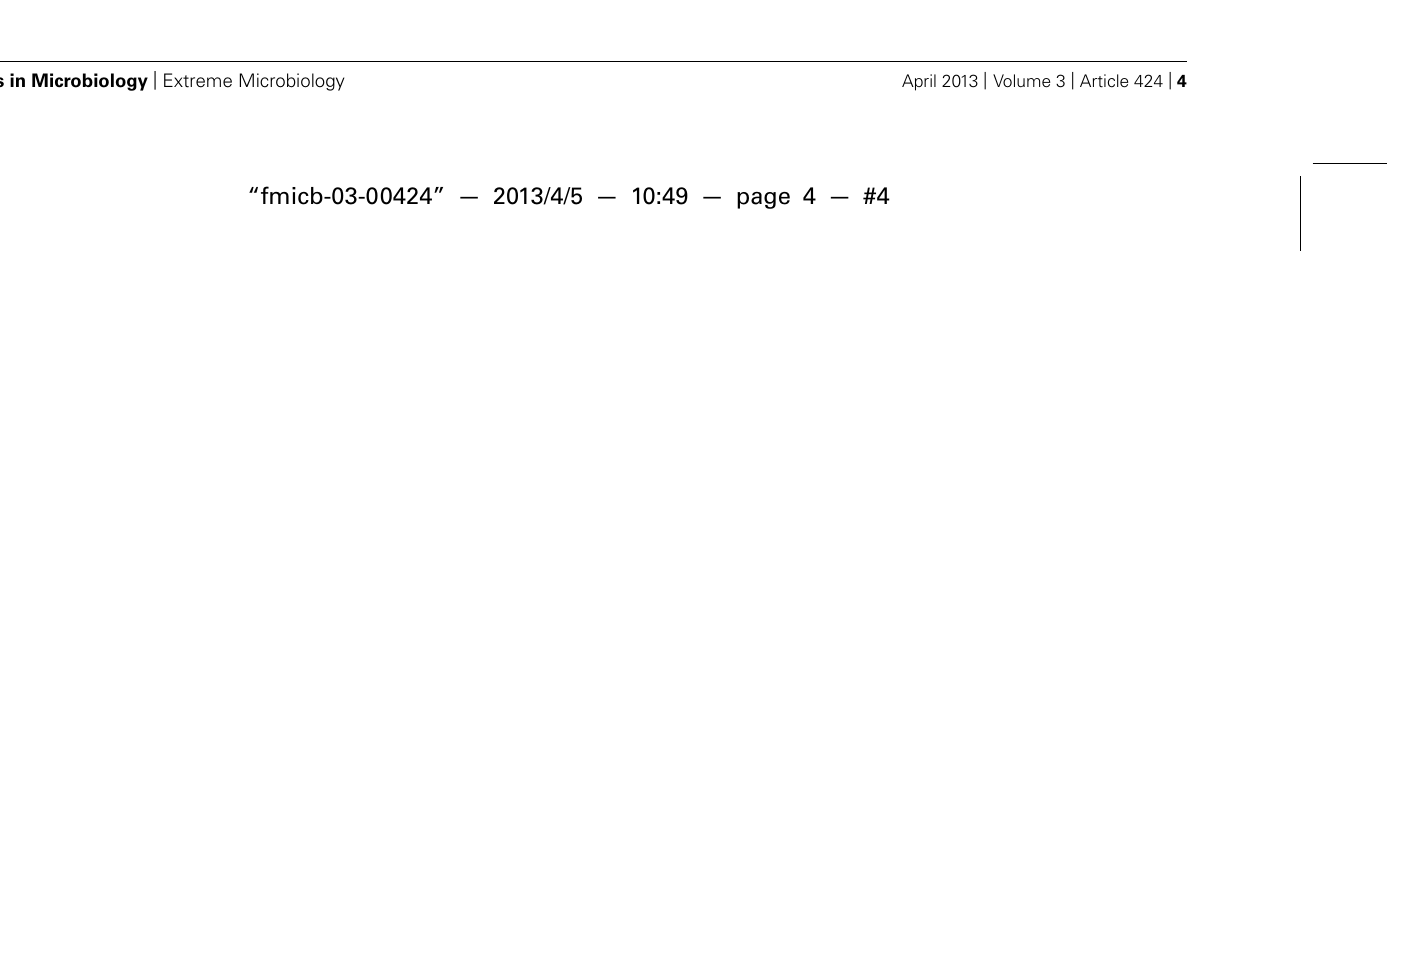
FIGURE 3 |Time series of xanthan concentration in full and fungal communities’ enrichments from top and bottom layers of a mature microbial mat during the dry season. Error bars represent the standard deviation of the